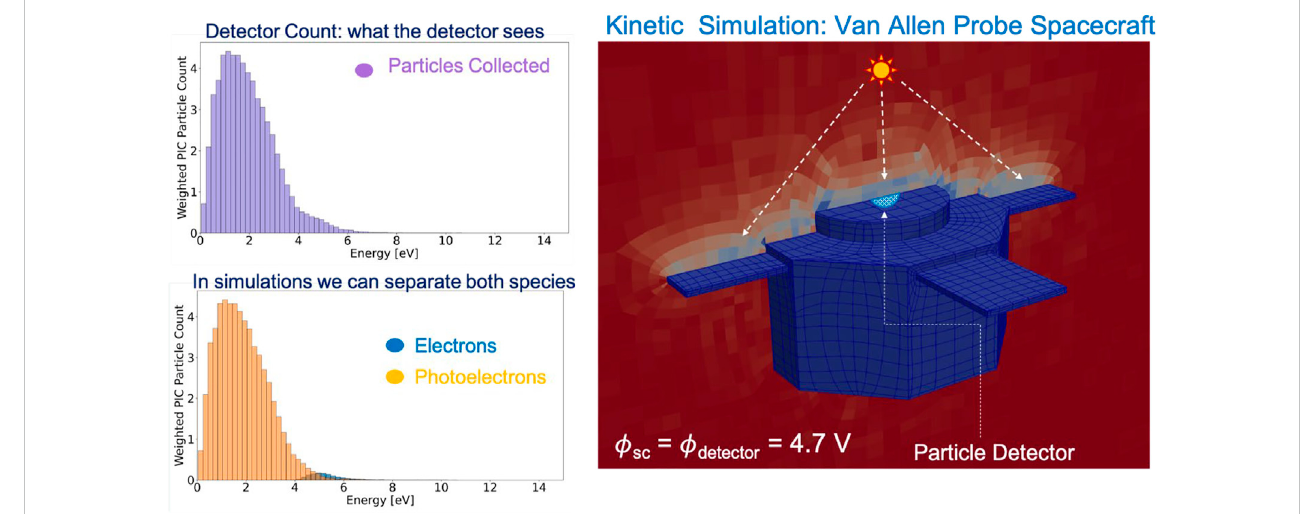
FIGURE 3 Kineticsimulationresult:photoelectronblindingthesignalofaparticledetectormountedonaVanAllenProbetypespacecraft.Plasmaparametersused in the simulation: n = 13.5 cm − 3 , T e (cid:2) 0 . 5 eV T i = 0.35 eV, T ph (cid:2) 2 eV and J ph = 100 μ A/m 2